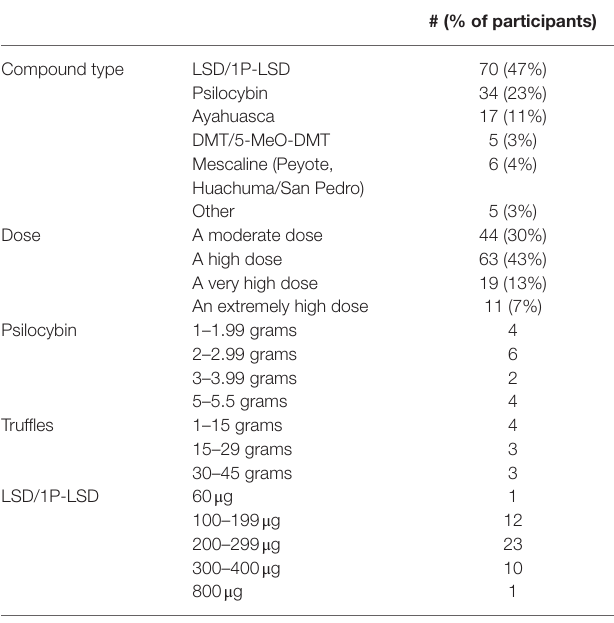
TABLE 2 | Pharmacology of sample’s psychedelic